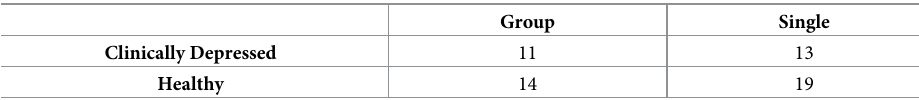
Table 5. Number of observations in the clinical sample by